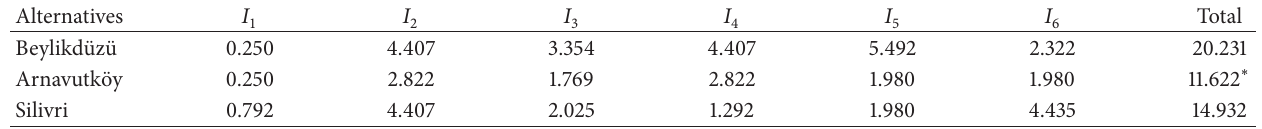
Table 8: Unit Index for unweighted information contents for European Side of